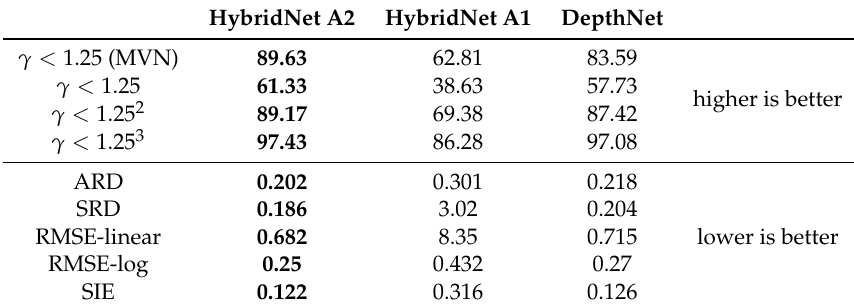
Table 6. Depth estimation. Quantitative evaluation: PP, PP-MVN, ARD, SRD, RMSE-linear, RMSE-log, and SIE (best results in